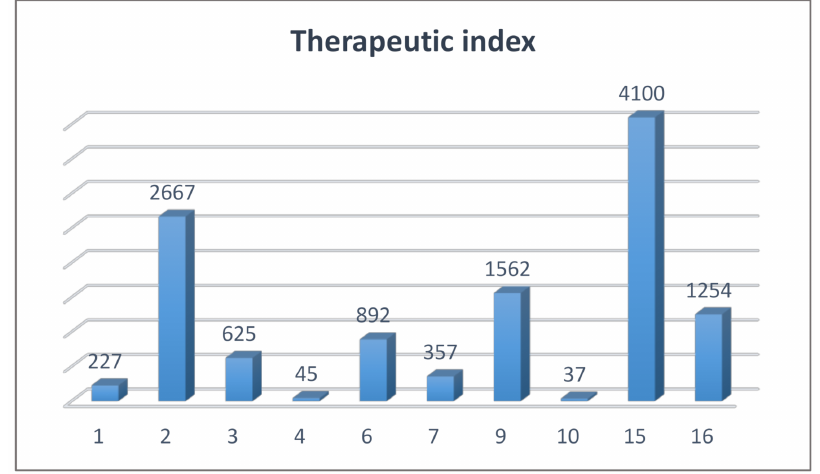
Figure 9. Therapeutic index (CC 50 / EC 50 ) values of the active